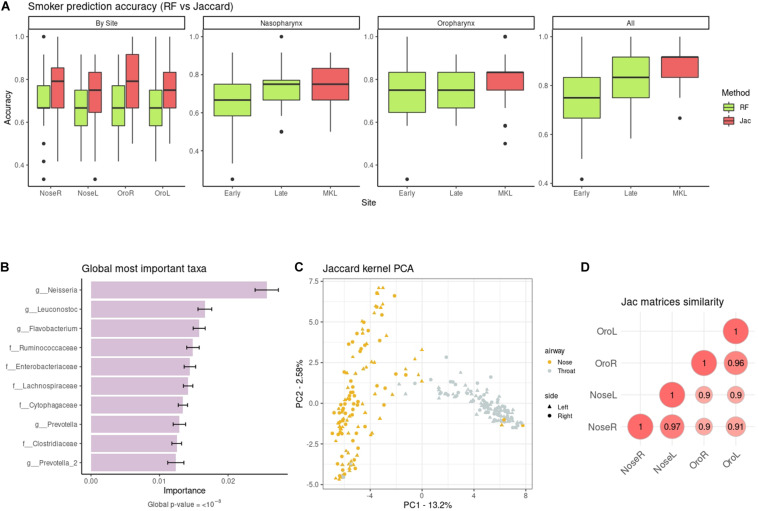
(A) Non-smoker/smoker accuracies from taxonomic data: RF (green) vs. the quantitative Jaccard kernel (red). NoseL, NoseR, OroL, and OroR models are obtained from single datasets, the Nasopharynx and Oropharynx panels contain the information from the right and left sides, and All the combination of the four datasets. Early and Late refer to the early integration and late integration approaches for RF. (B) Top ten global cLin-SVM importances across all body sites. (C) Similarity across the Jaccard kernel matrices of the four sites (Nasopharynx Right and Left and Oropharynx Right and Left). (D) Jaccard kPCA of the taxonomic abundances. Color code represent airway site, whereas shape indicates the laterality of the samples.